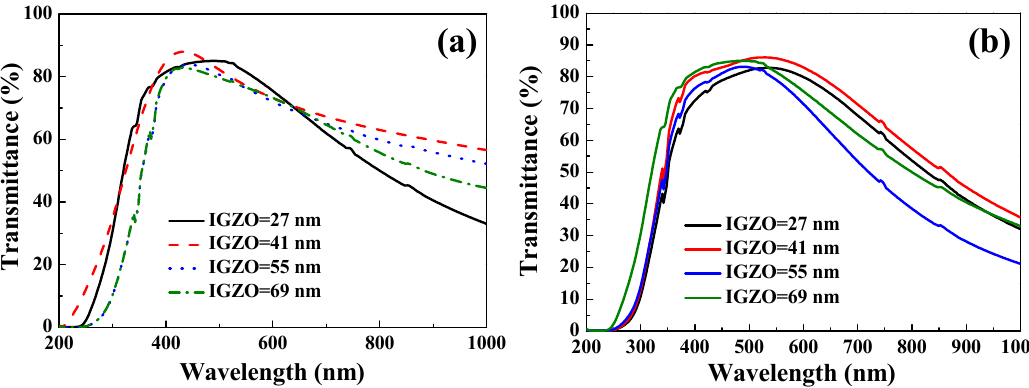
Figure 8. UV-vis spectra of the α -IGZO/Ag/ α -IGZO triple-layer structure as a function of thickness of IGZO films. On ( a ) glass substrates; and ( b ) PET substrates.